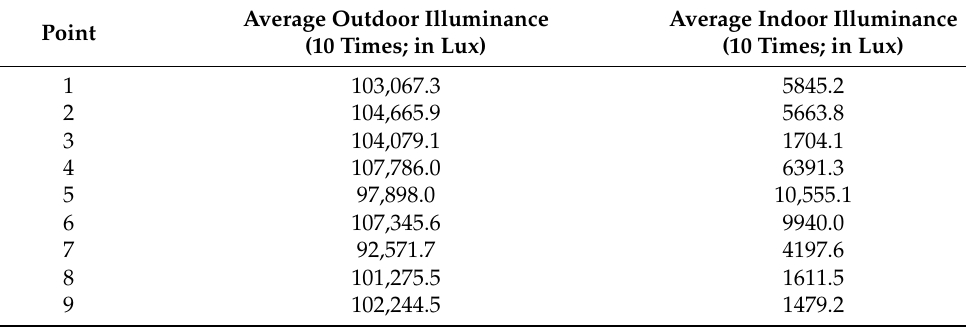
Table 1. Comparison of outdoor and indoor illuminance measurement